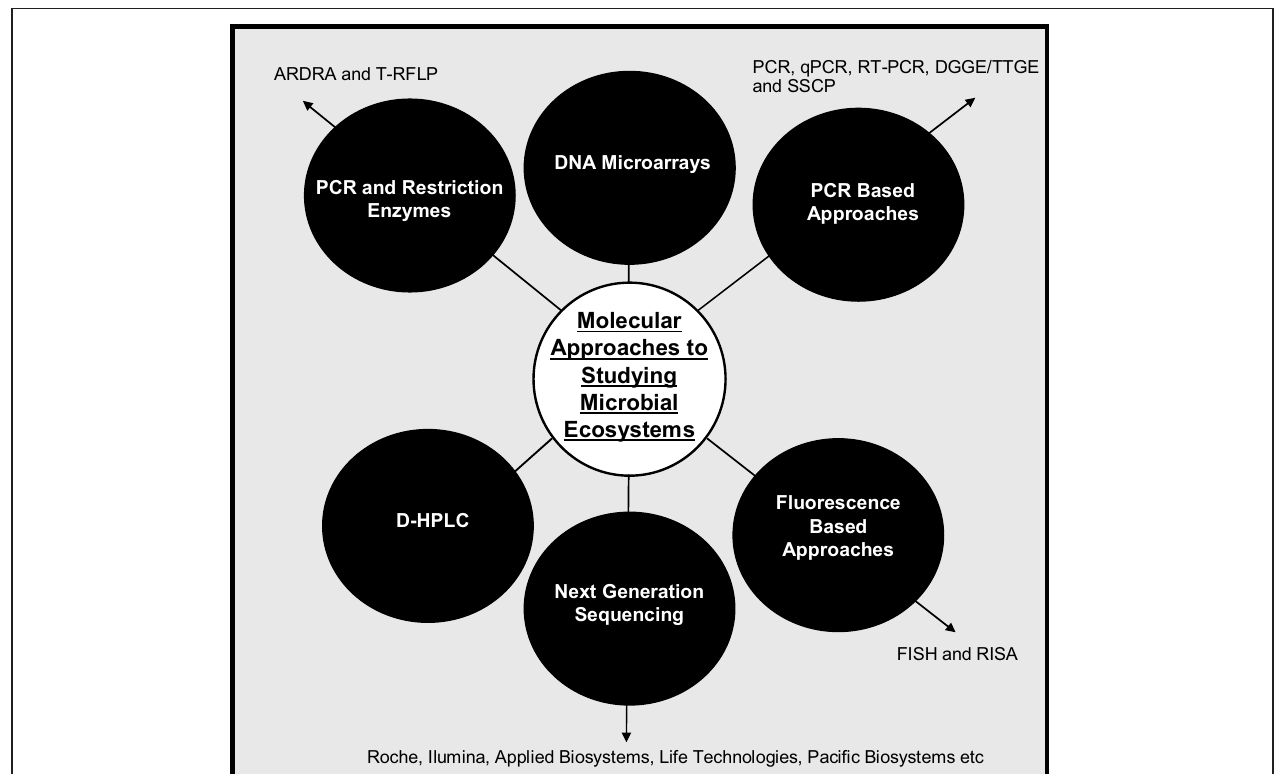
FIGURE 2 | Methods of profiling microbial